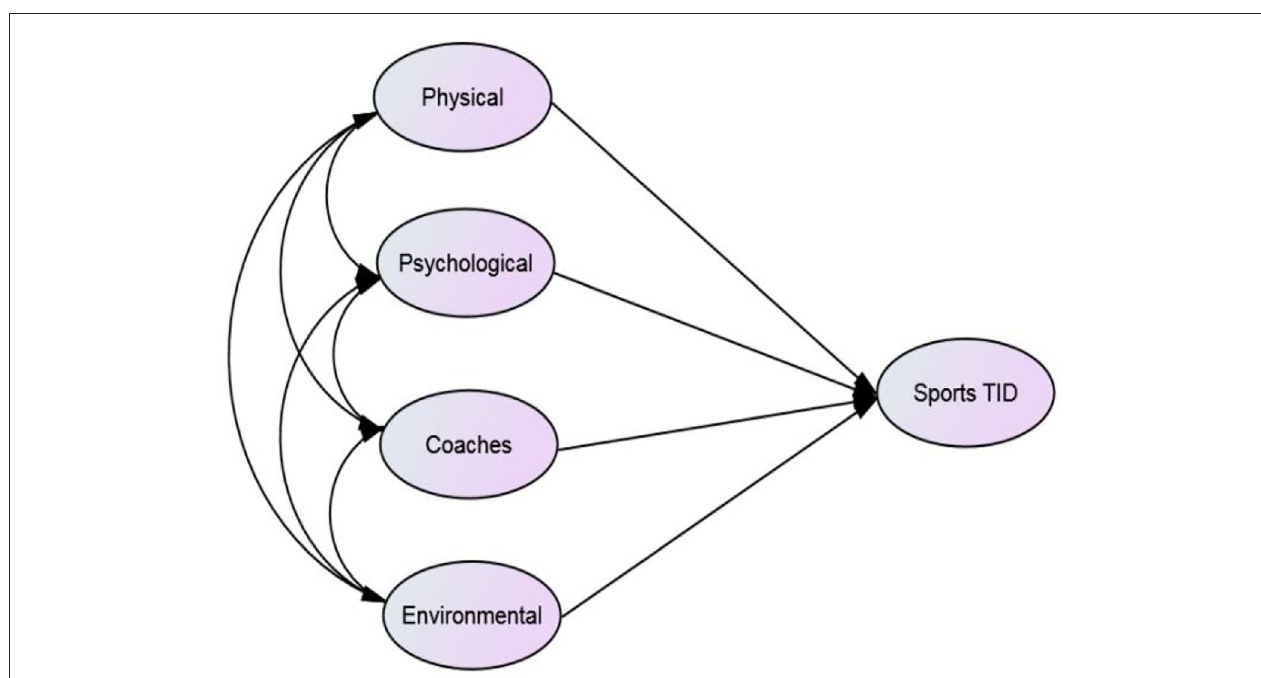
FIGURE 1 | Theoretical model.